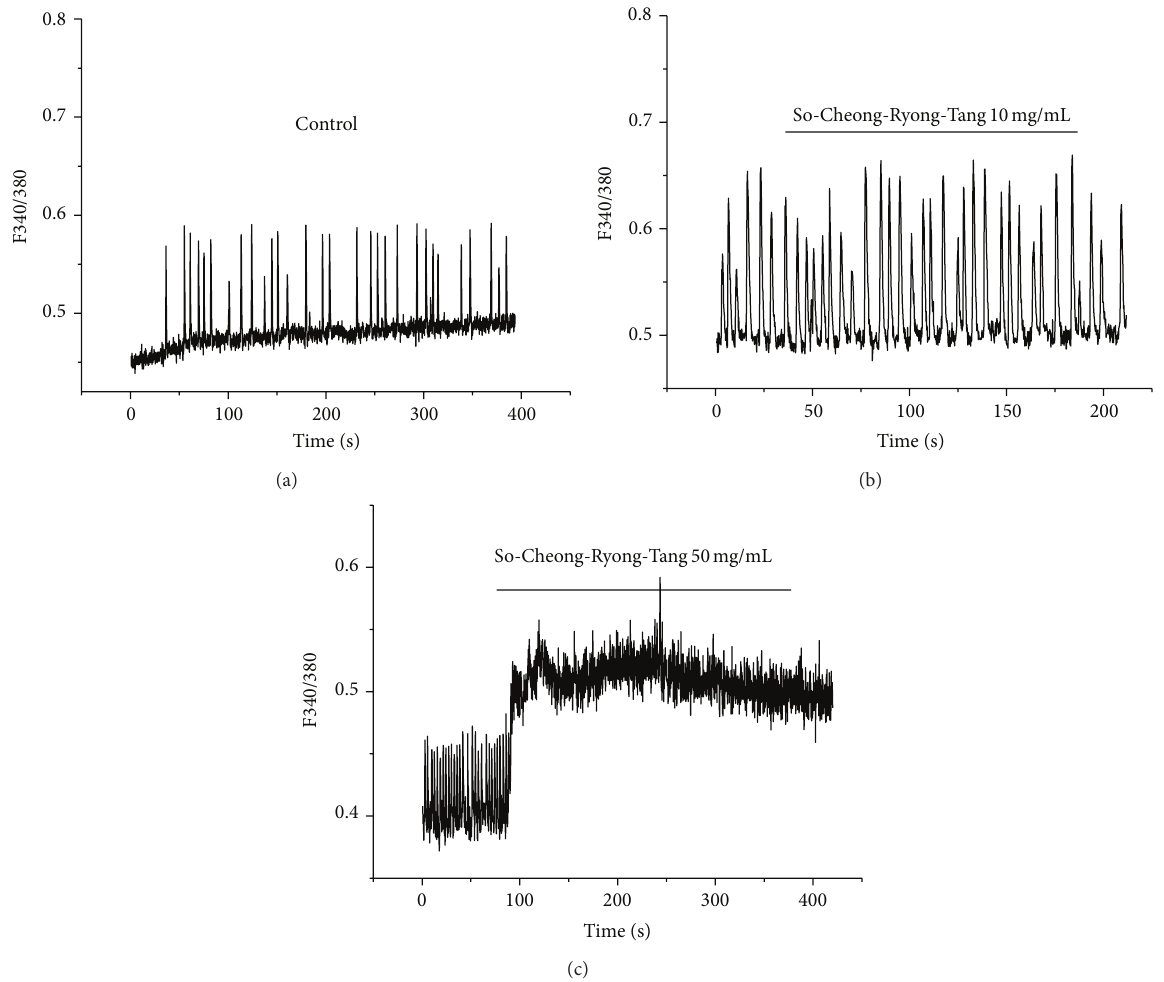
Figure4:ResponsesofintracellularCa 2+ toSCRTinculturedICCs.ICCsweresuspendedin2mMCa 2+ -containingnormalsolution.Increase was plotted against SCRT concentrations. (a) In normal conditions, [ Ca 2+ ] in [ Ca 2+ ] i